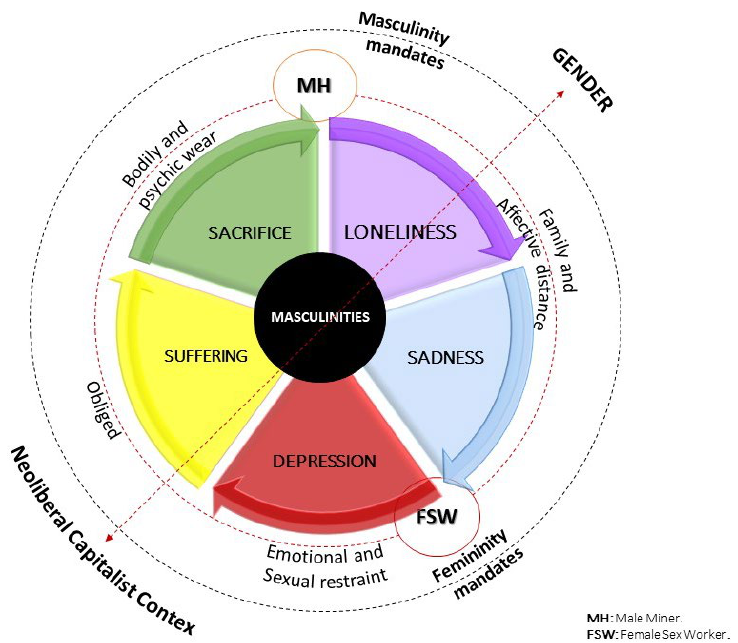
Figure 2. Results analysis model. Source: Author’s elaboration.